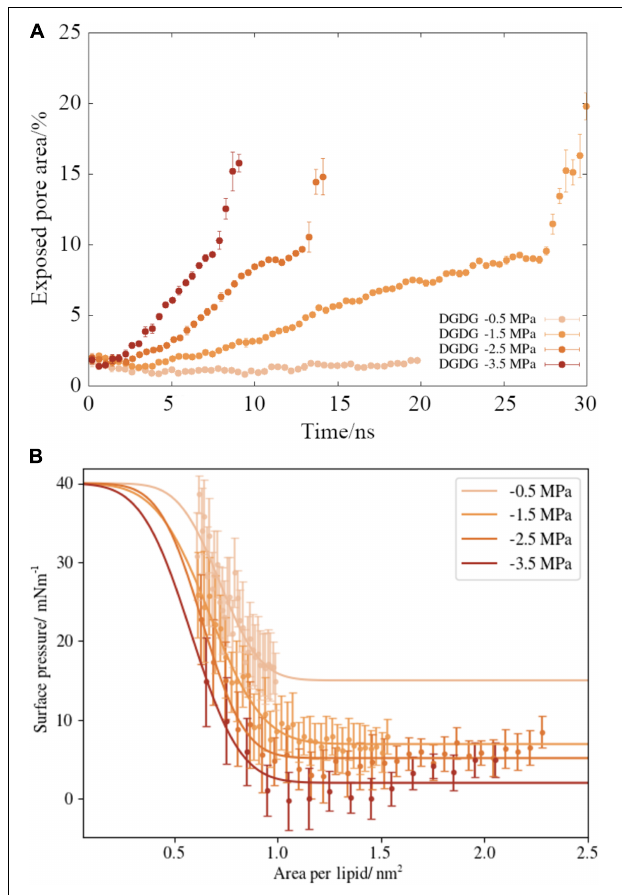
FIGURE 5 | (A) Time dependent ruptured pore area for digalactosyldiacylglycerol DGDG monolayers, as a function of (external) negative pressure. Values calculated after the water slab began to rupture have been removed for clarity. (B) Surface pressure area isotherms for the same monolayer pulling simulations (points), alongside best fits to Equation (6) (lines). Error bars represent one standard deviation of the averaged